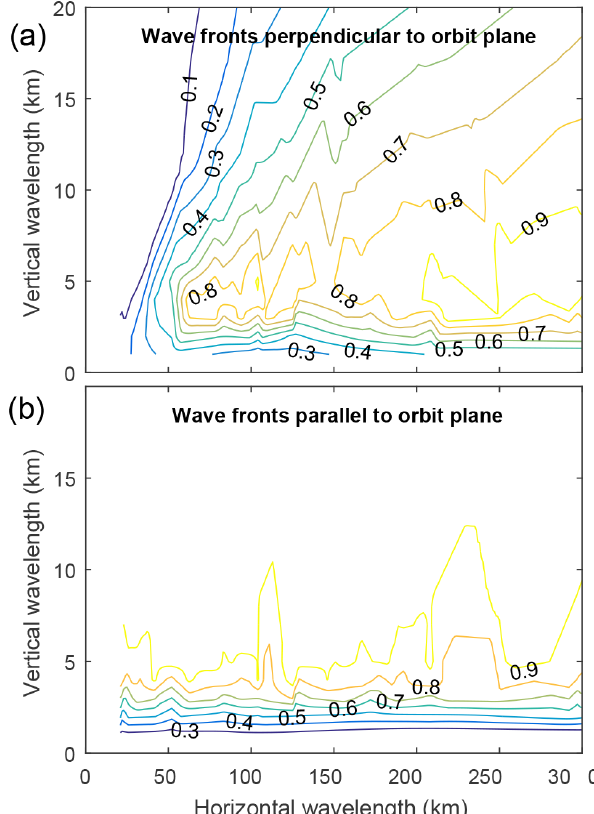
Figure 11. Simulated sensitivity of the MATS instrument to gravity waves of varying horizontal and vertical wavelengths. The sensi- tivity is defined as the ratio between the amplitude of the retrieved wave and the amplitude of the true wave field. Results are shown for waves with wave fronts perpendicular to the orbit plane (a) and parallel to the orbit plane (b)